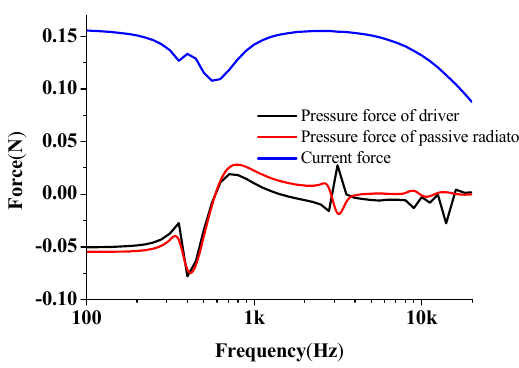
Figure 9. Force acting on driver and passive radiator.